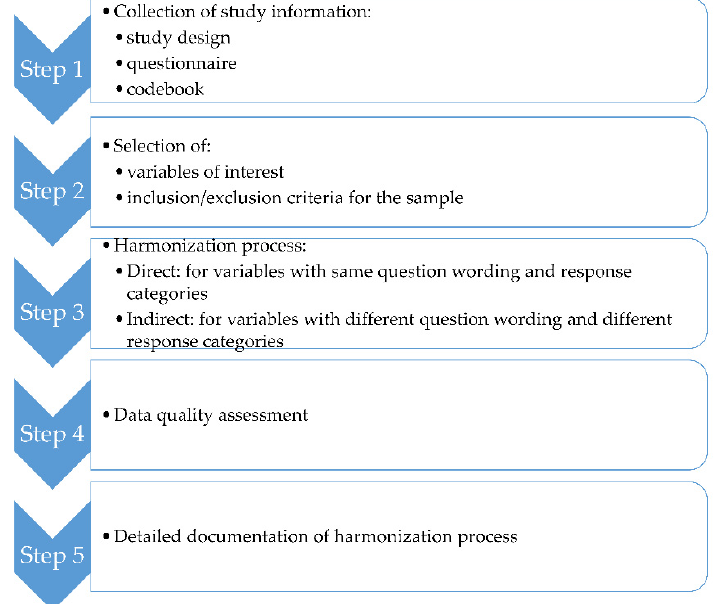
Figure 2. Steps of the harmonization